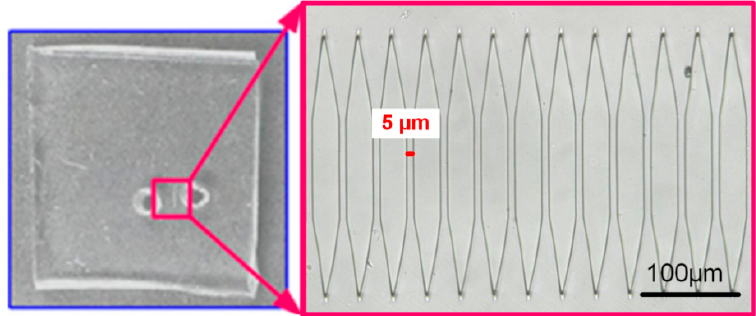
Figure 3. Chip-based microfluidic device.